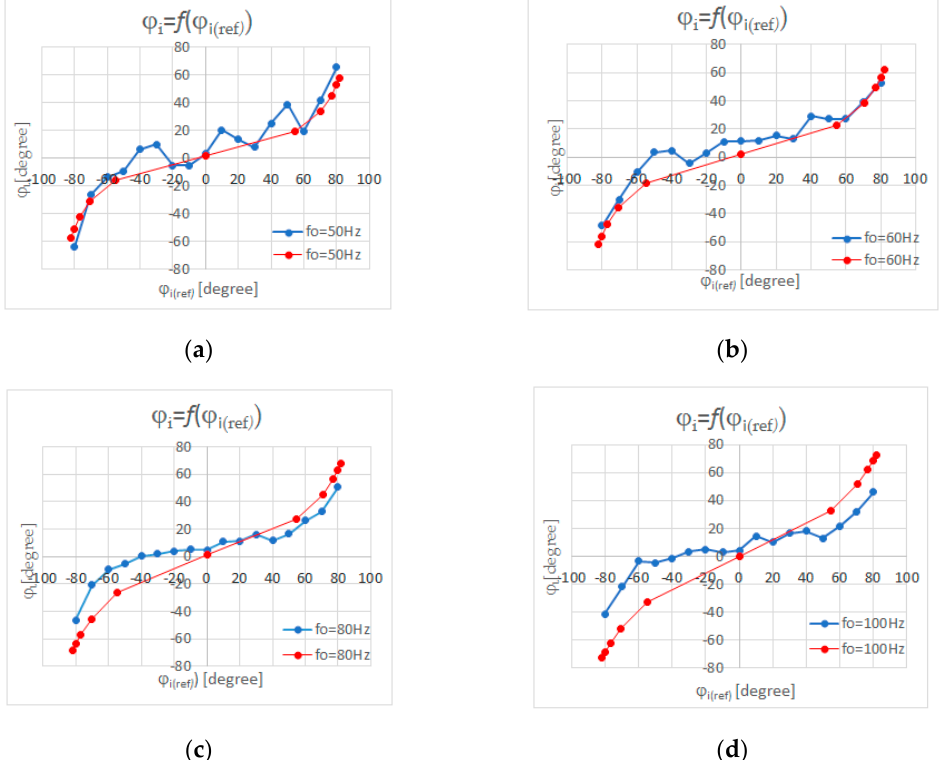
Figure 12. Input displacement angle in the function of referenced input displacement angles for different values of output frequency in three-to-nine-phase MC: Results of simulation (red line); result of measurements (blue line). ( a ): f o = 50 Hz; ( b ): f o = 60 Hz; ( c ): f o = 80 Hz; ( d ): f o = 100 Hz.